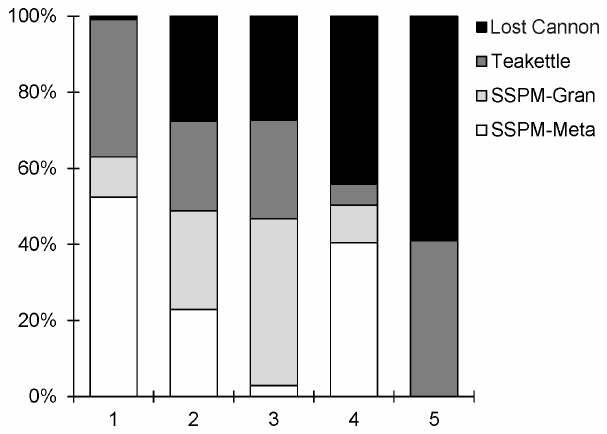
Figure 10. Principal components analysis (bottom right graph) identified several forest structure variables in characterizing 534 tree patches from four stem-mapped plots. Boxplots summarize forest structure variables by groups of patches (top and left graphs) using cluster analysis, which maintained statistical significance (within a boxplot, group number with same superscript are not significantly different; p-value , 0.05). Lines inside boxes is the median; boxes show the interquartile range (25–75%) and vertical lines represent the range 10–90%. Width of the boxes is proportional to the square root of the number of patches in the group.